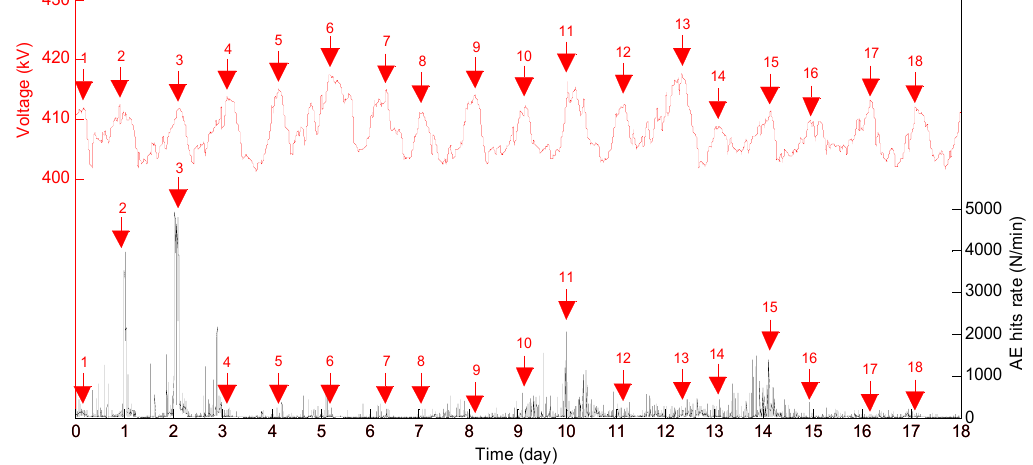
Figure 3. Relation between PD activity (AE hits rate per minute) and voltage changes (voltage peaks are marked by arrows) during 18 days of monitoring a 330 MVA/400 kV power transformer.